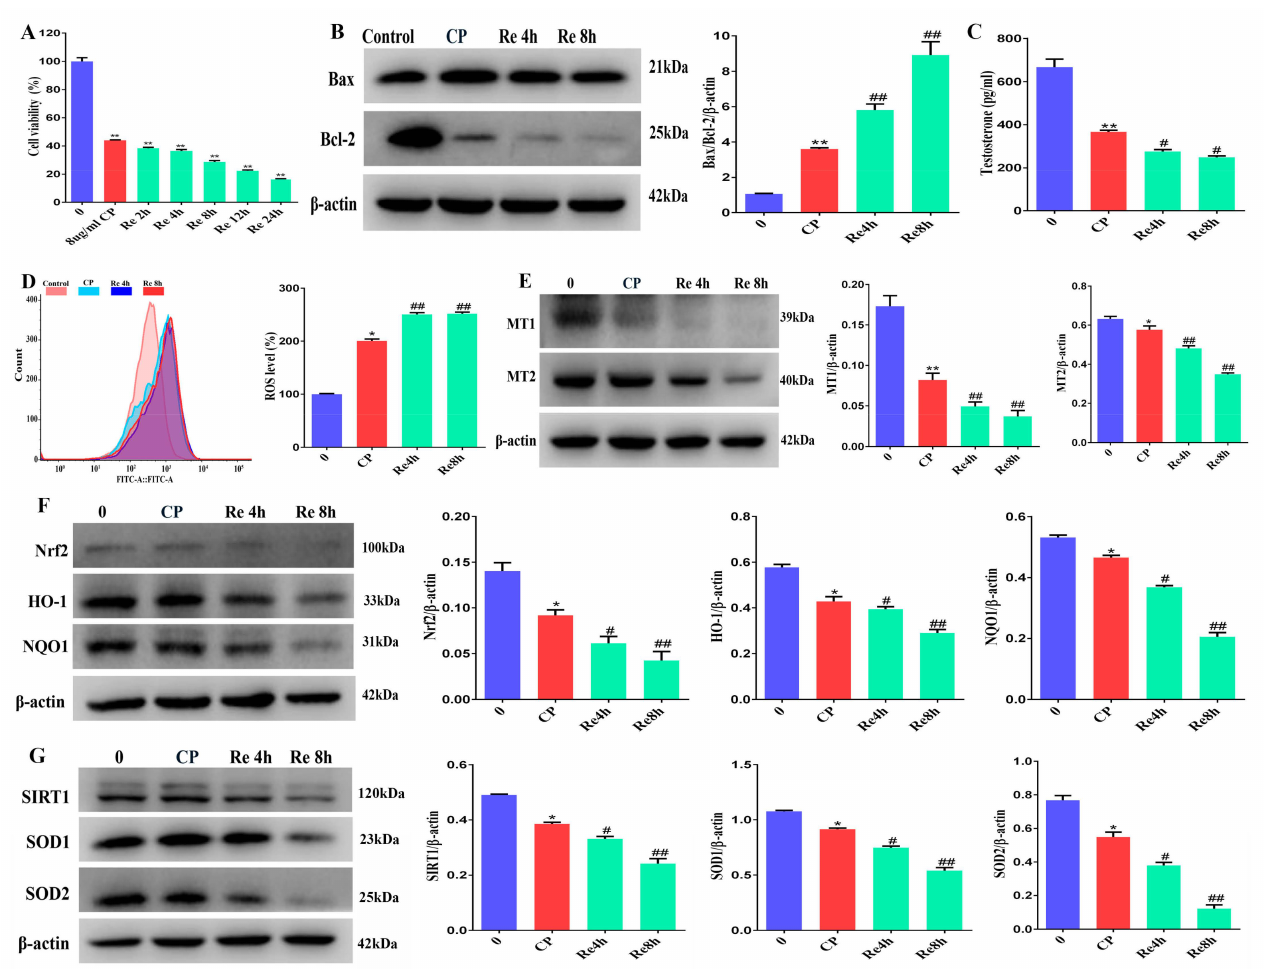
Figure 9. Leydig cells failed to self recover after removing cisplatin. ( A ) CCK8 was used to determine the relative cell viability of Leydig cells treated with 8 µ g/mL cisplatin and removal of cisplatin recovery for 2 h, 4 h, 8 h, 12 h, and 24 h. ( B ) Determination of Bcl-2 and Bax protein levels was performed by Western blotting in Leydig cells treated with 8 µ g/mL of cisplatin and removal of cisplatin recovery for 4 h and 8 h. The blots were quantified using Image J software. ( C ) Content of testosterone in Leydig cells treated with 8 µ g/mL of cisplatin and removal of cisplatin recovery for 4 h and 8 h. ( D ) Flow cytometry was used to measure the concentrations of reactive oxygen species in Leydig cells treated with 8 µ g/mL of cisplatin and removal of cisplatin recovery for 4 h and 8 h; ROS were detected by DCFH-DA staining. ( E ) Determination of MT1 and MT2 protein levels was performed by Western blotting in Leydig cells treated with 8 µ g/mL cisplatin and removal of cisplatin recovery for 4 h and 8 h. The blots were quantified using Image J software. ( F ) Determination of Nrf2, HO-1, and NQO1 protein levels was performed by Western blotting in Leydig cells treated with 8 µ g/mL cisplatin and removal of cisplatin with recovery for 4 h and 8 h. The blots were quantified using Image J software. ( G ) Determination of SIRT1, SOD1, and SOD2 protein levels was performed by Western blotting in Leydig cells treated with 8 µ g/mL cisplatin and removal of cisplatin with recovery for 4 h and 8 h. The blots were quantified using Image J software. CP, cisplatin. Re, recovery. Data are presented as the mean ± SEM ( N = 4 per group). * p < 0.05 or ** p < 0.01 compared with controls. # p < 0.05 or ## p < 0.01 compared with CP